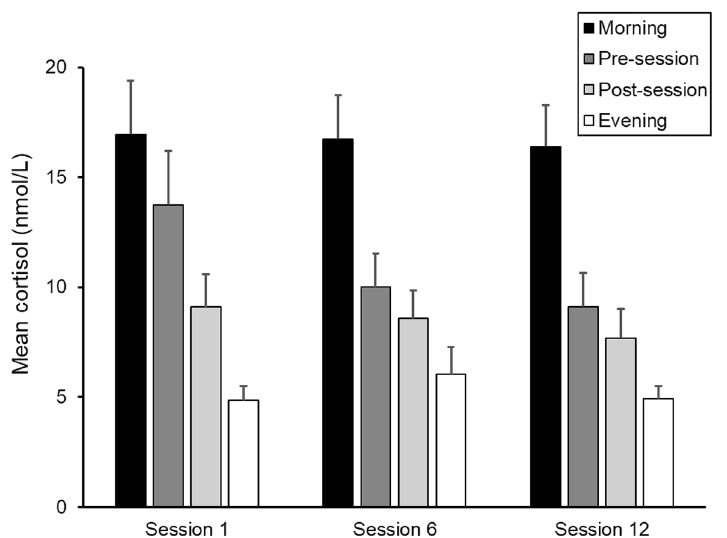
Figure 3. Salivary cortisol level in the morning, before session, after session, and in the evening, at sessions 1, 6 and 12 in the intervention group. Error bars represent 1 standard